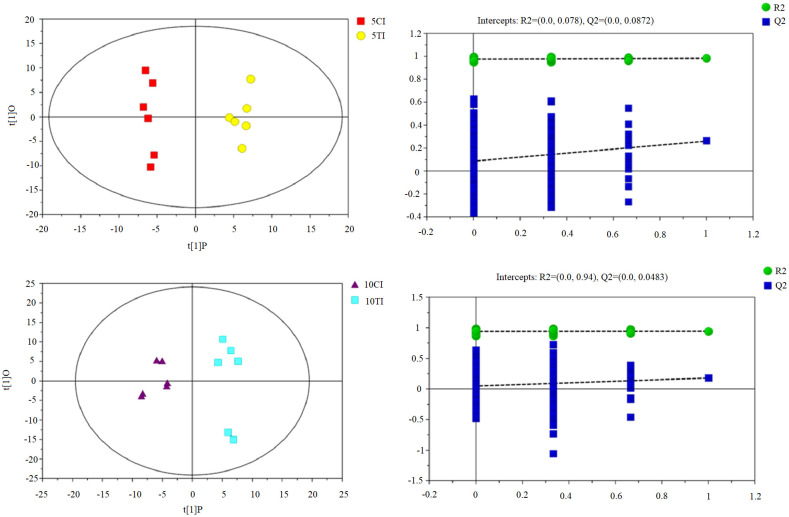
OPLS-DA model analysis performed on the most diverse sample at (A) day 5 and (B) day 10 post-inoculation.CI indicates SCN-inoculated mock-treated soybean roots and TI indicates SCN-inoculated Sneb545-treated soybean roots.